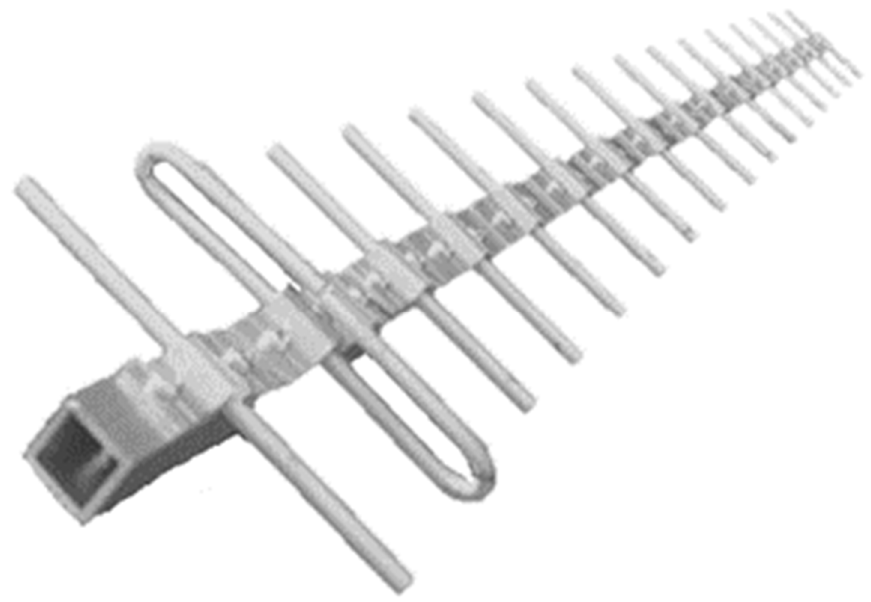
Figure 8. Handmade Yagi Antenna.